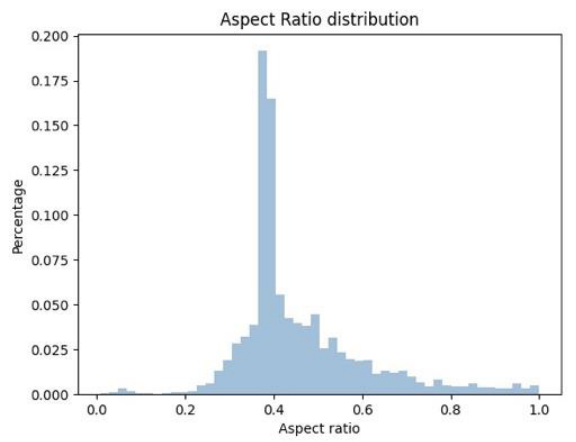
Figure 3. Histogram of pedestrian aspect ratio in the Caltech-USA dataset.